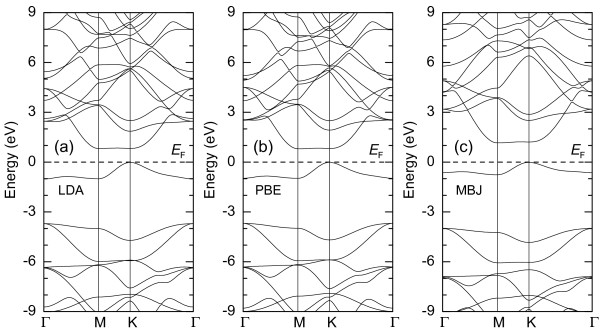
Calculated band structures for α-g-B3N3C model with the three XC potentials.(a) LDA XC potential. (b) PBE XC potential. (c) MBJ XC potential.